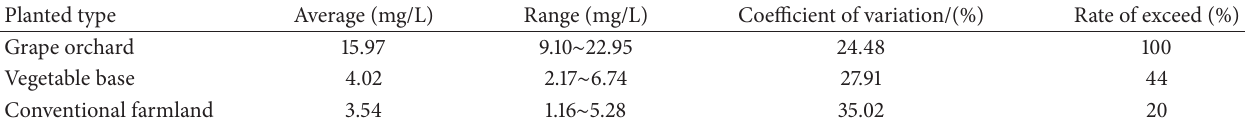
-N in three different cropped farmlands. 3